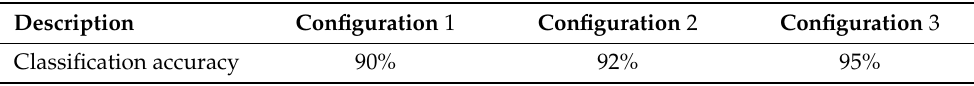
Table 4. Classification accuracy level of different walking